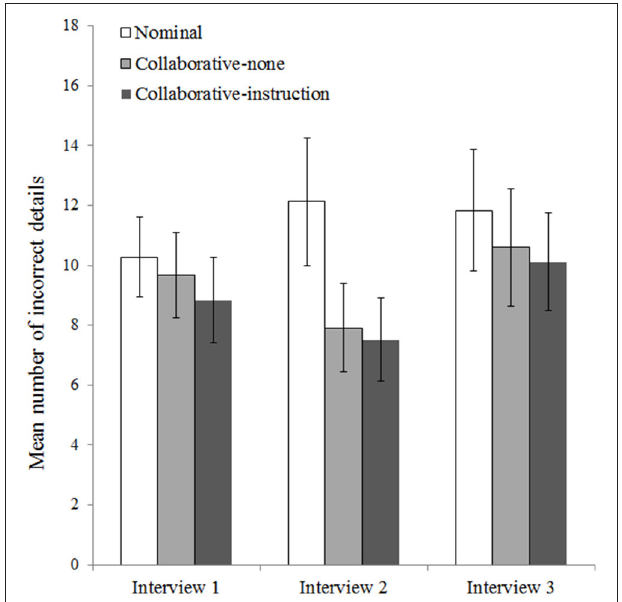
FIGURE 2 | Mean number of incorrect details mentioned by pairs in the nominal ( n = 25), collaborative-none ( n = 25), and collaborative-instruction ( n = 25) conditions during the first, second, and third interview. Error bars represent 95% confidence intervals.